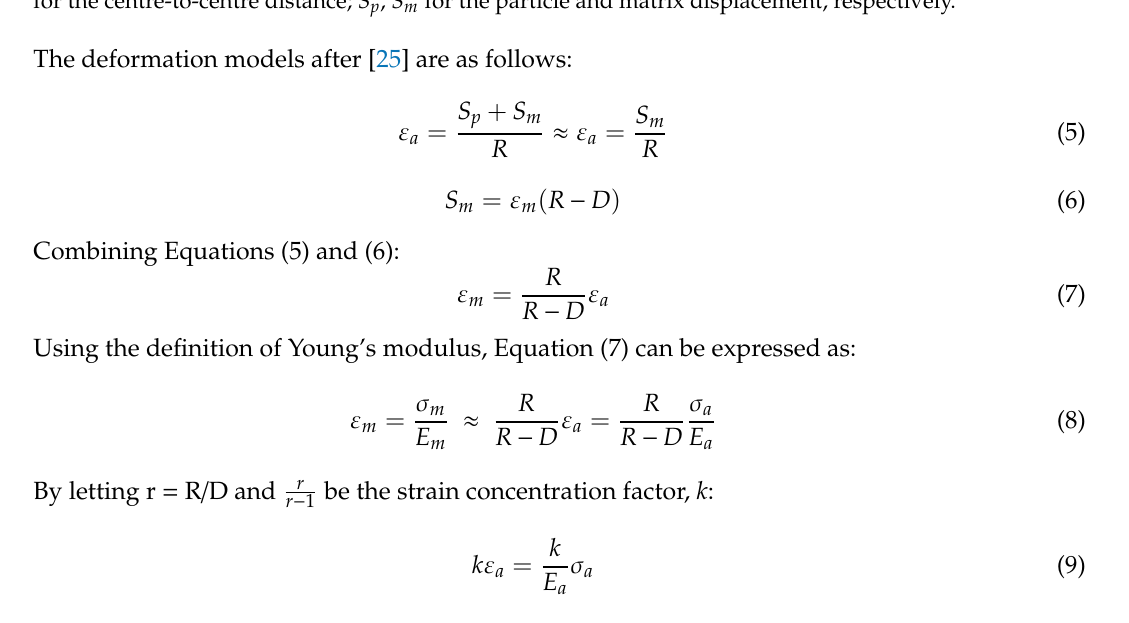
Figure 13. Two neighbouring particles debonding model, σ a , ε a , for the applied stress and strain, R, for the centre-to-centre distance; S p , S m for the particle and matrix displacement,